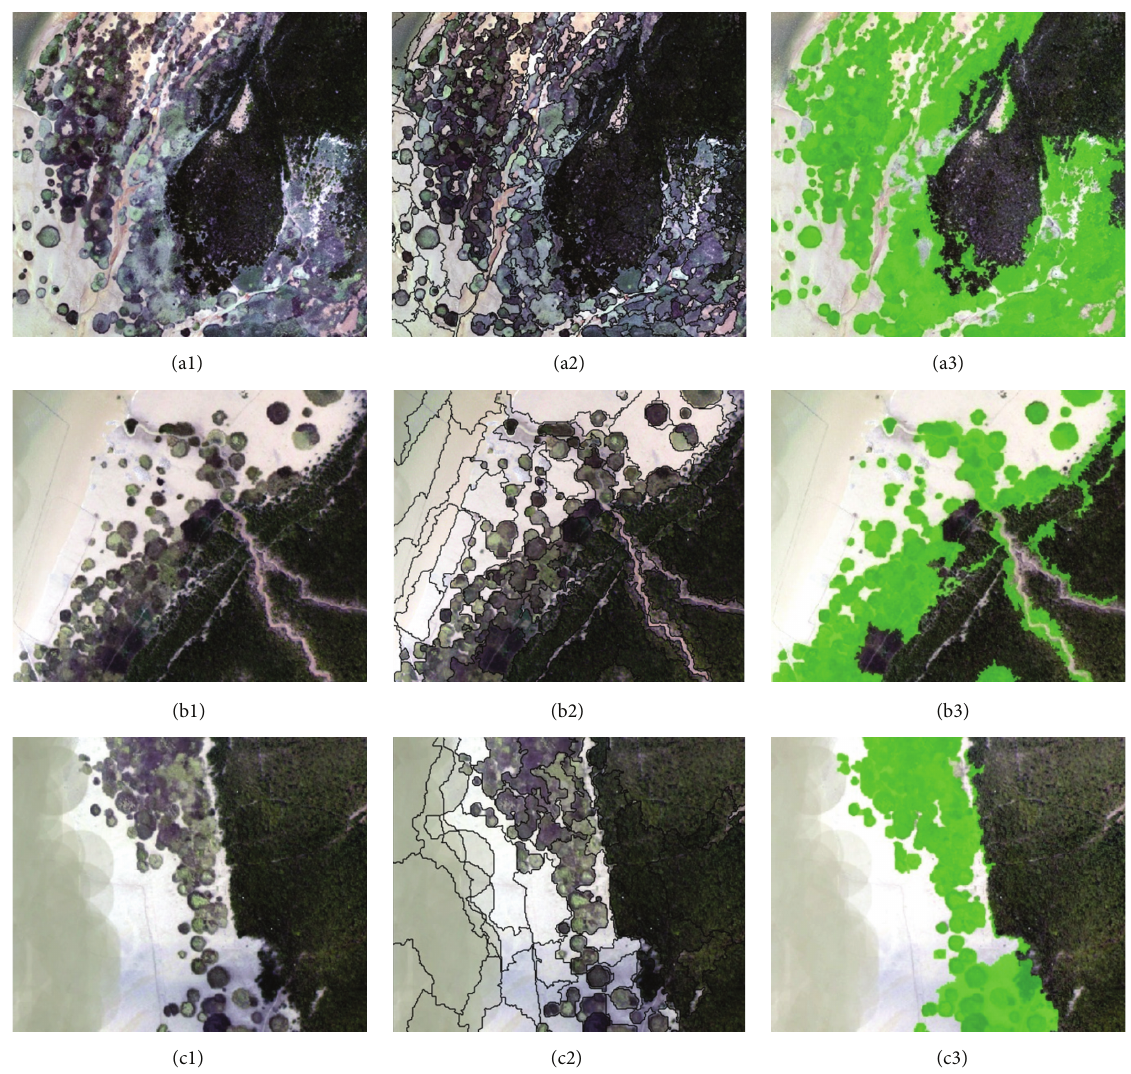
Figure 3: Three typical regions from north of Dandou Sea ((a1) to (a3)), south of Dandou Sea ((b1) to (b3)), and Shatian port ((c1) to (c3)) were selected. (a1)–(c1) shows the original VHR image; the segmentation parameters of the three parts are scale 40, shape 0.1, and compactness 0.5 and the results are (a2)–(c2); the features for extracting S. alterniflora from (a3) and (c3) are “Mix diff ≤ 0.09, brightness: 105–136” and the features for extracting S. alterniflora from (b3) are “Mix diff ≤ 0.08, brightness ≤